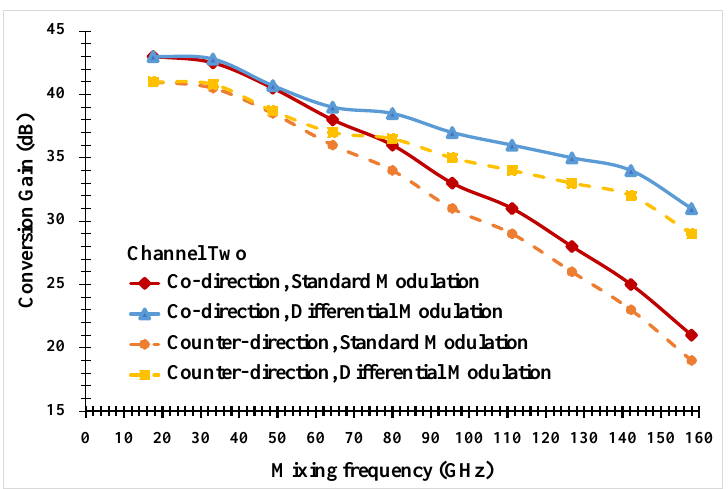
Figure 12. Up-conversion gain at different mixing frequencies for the standard and differential modulation modes in the co- and counter-directions. The IF2 signal at 𝑓 2 = 2 GHz is up-converted at 𝑛𝑓 𝑠 + 𝑓 2 .